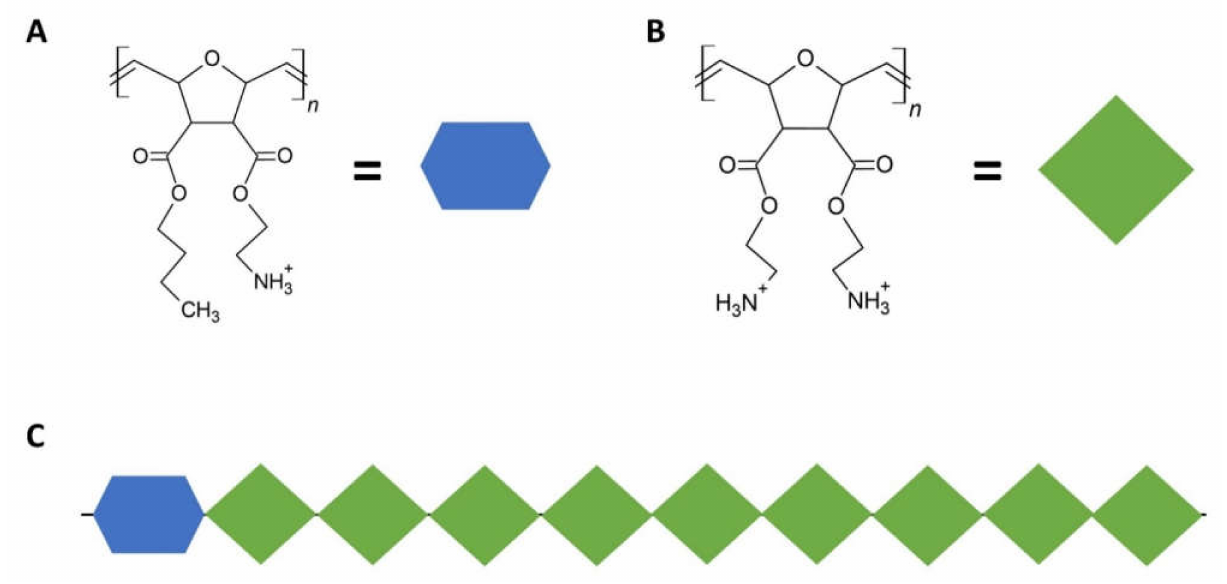
Figure 4. Principles of the design of synthetic mimics of antimicrobial peptides (SMAMPS). The SMAMPS described in the main text are based on a poly(oxanorbornene) backbone. ( A ) shows the chemical structure of unit 1 (U1; see main text), which is a monomer from a poly(oxanorbornene) structure. The side chains are composed of a butyl residue (left side) and a positively charged ethylamine (right side). ( B ) Unit 2 (U2; see main text) differs from U1 in that the butyl chain was replaced by another ethylamine residue, yielding two positive charges per monomer. ( C ) Schematic representation of a complete SMAMP composed of 1 U1 and 9 U2 subunits, which, therefore, has a considerable number of positive charges and leads to the selective killing of various bacteria. Details are given in the main